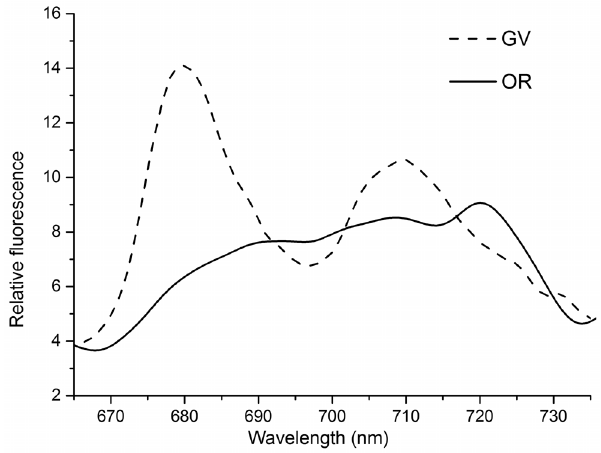
Figure 8. Low temperature (77K) fluorescence emission spectra. The excitation wavelength was set at 436 nm and slit width was set at 5 nm for both excitation and detection. Spectra were normalized to area below the curve from 665 to 735 nm. Two prominent chlorophyll fluorescence emission peaks were observed for GV – a peak at 680 nm from PSII and peak at 710 nm from PSI; the peak at 680 nm was found to be much higher than that at 710 nm. However, OR contained no comparable peaks to GV. Dashed line represents GV and solid line represents OR. doi:10.1371/journal.pone.0067028.g008 PLOS ONE |